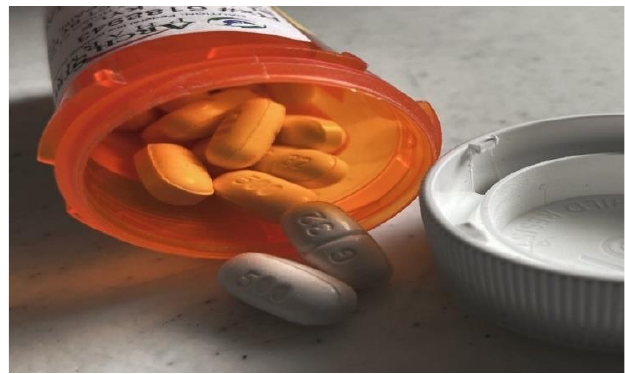
Figure 4. Challenges with inappropriate use of drugs/self-medicating.